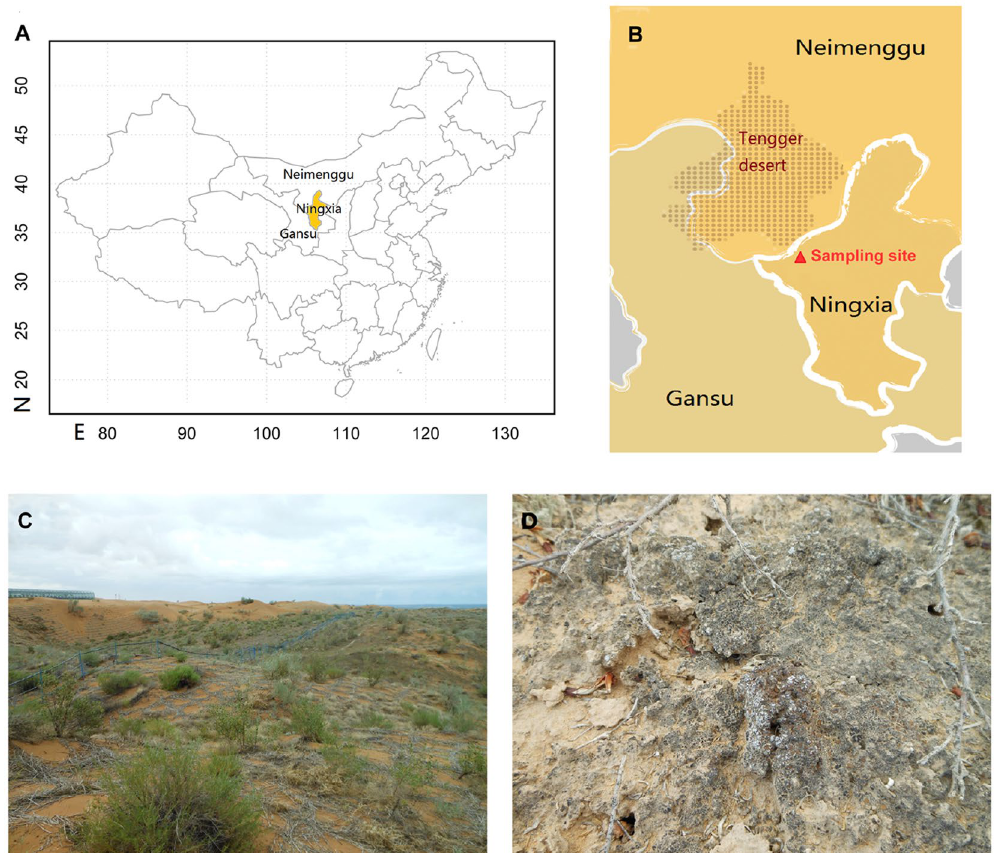
Figure 1. The location of sampling site and field overview. ( A ) The location of the sampling site in China, highlighted with orange color (created using R3.4.0); ( B ) Partial magnification of the detailed sampling site marked by a solid red triangle, situated in Ningxia Hui Autonomous Region and the southeast edge of the Tengger Desert (created using the drawing tool software Microsoft Paint (Windows 8.0); ( C ) Field overview of the sampling site; ( D ) Detailed view of Endocarpon spp. in the